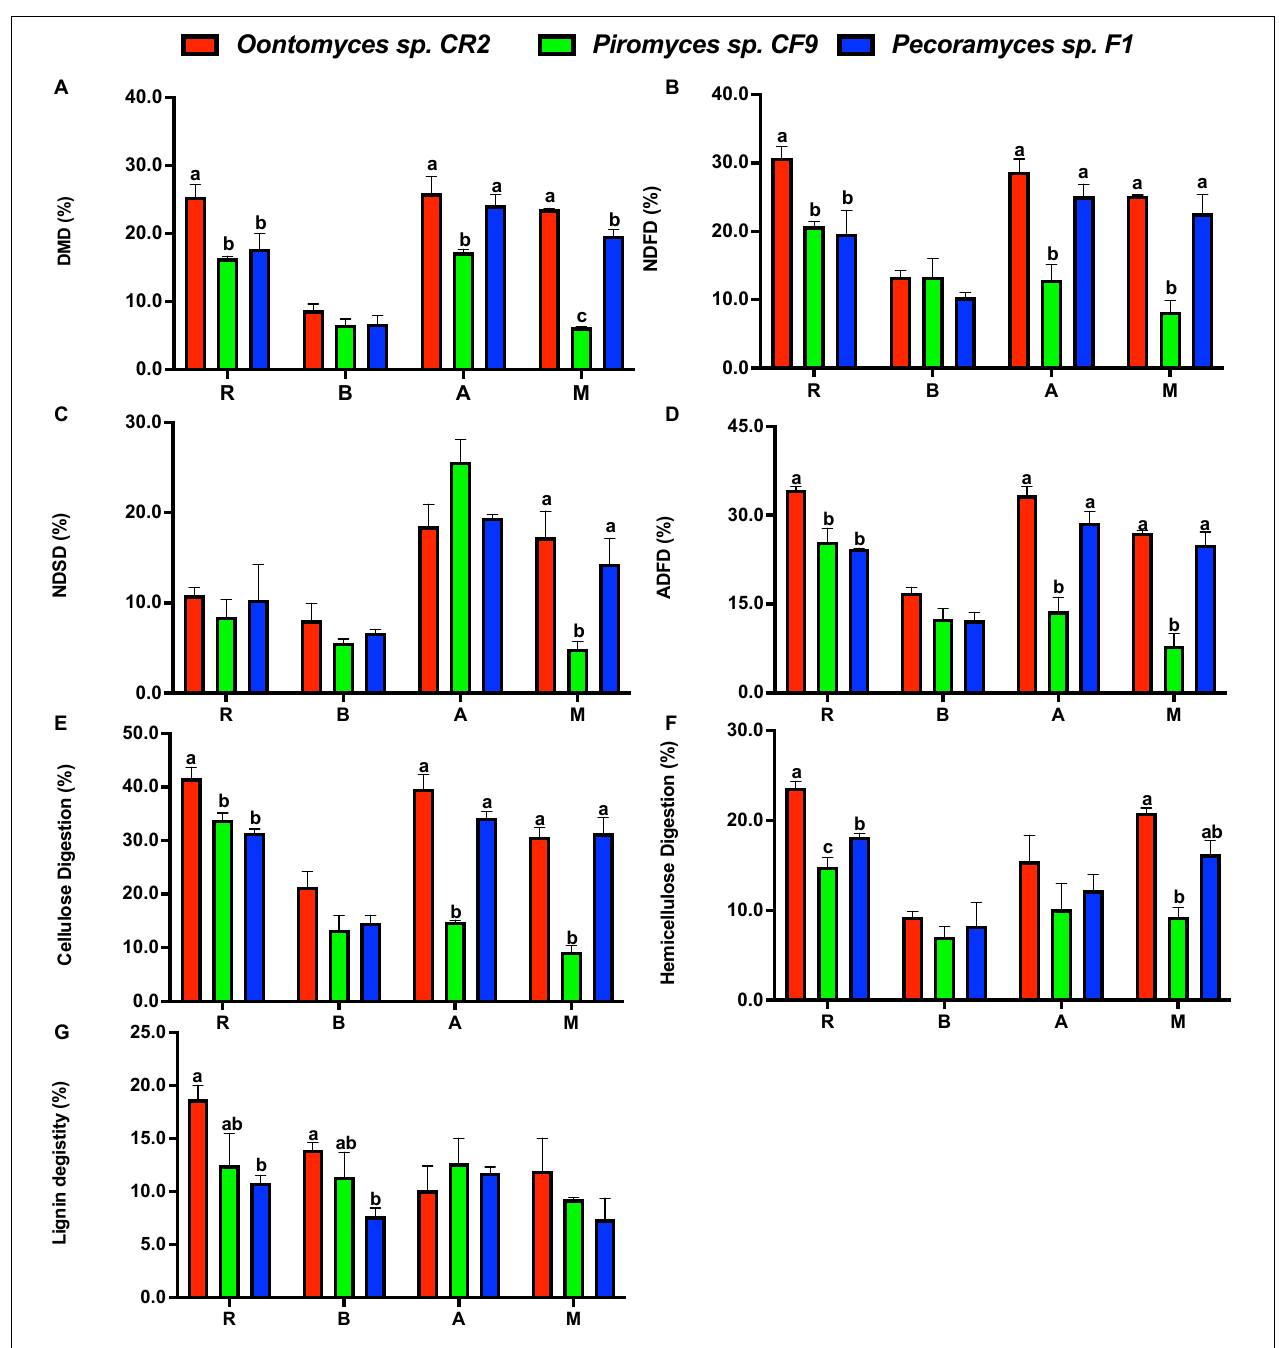
FIGURE 4 | Degradation of reed, alfalfa stalk, Broussonetia papyrifera leaves, and Melilotus officinalis after fermentation. The figure includes DMD (A) , NDF digestion (B) , NDS digestion (C) , ADF digestion (D) , cellulose digestion (E) , hemicellulose digestion (F) and lignin digestion (G) (R, Reed; B, Broussonetia papyrifera leaves; A, Alfalfa stalk; M, Melilotus officinalis ). The error bars represent the standard error of the mean ( n = 4), and means with different letters in the same column are different at P <